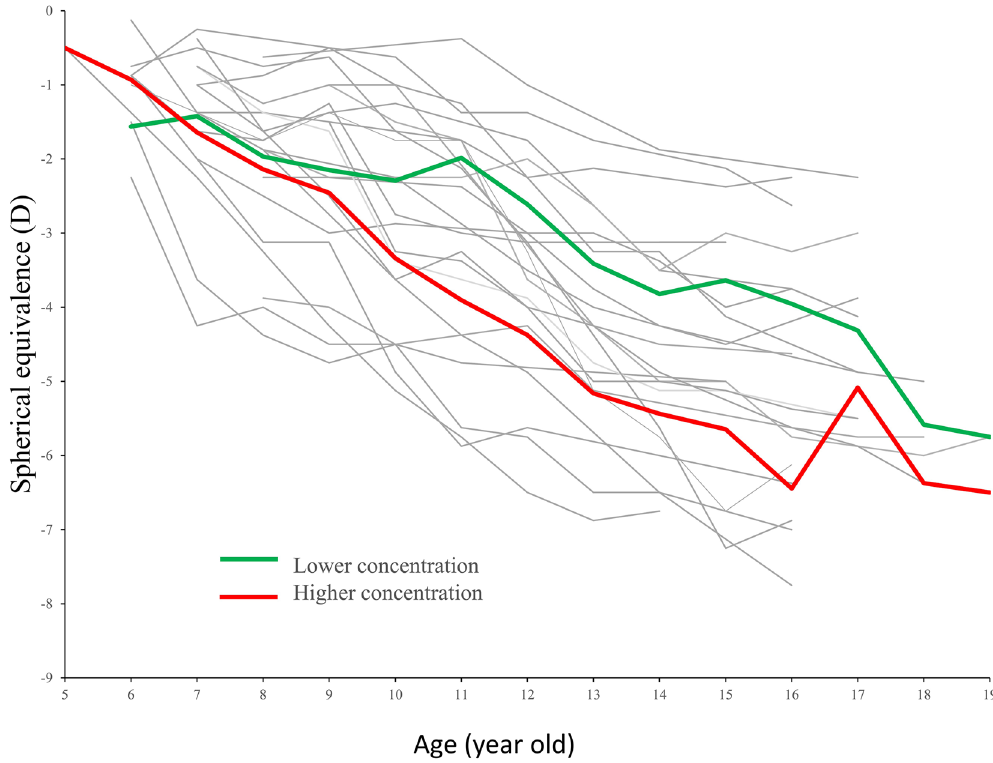
Figure 2. Spherical equivalence and the age of each individual subject.